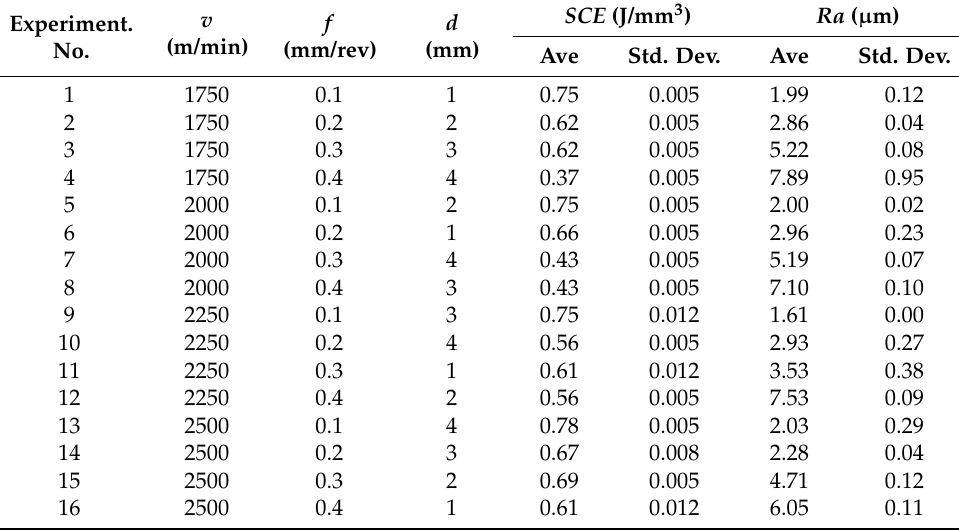
Table 12. Results of L 16 experimental plan for HSM.